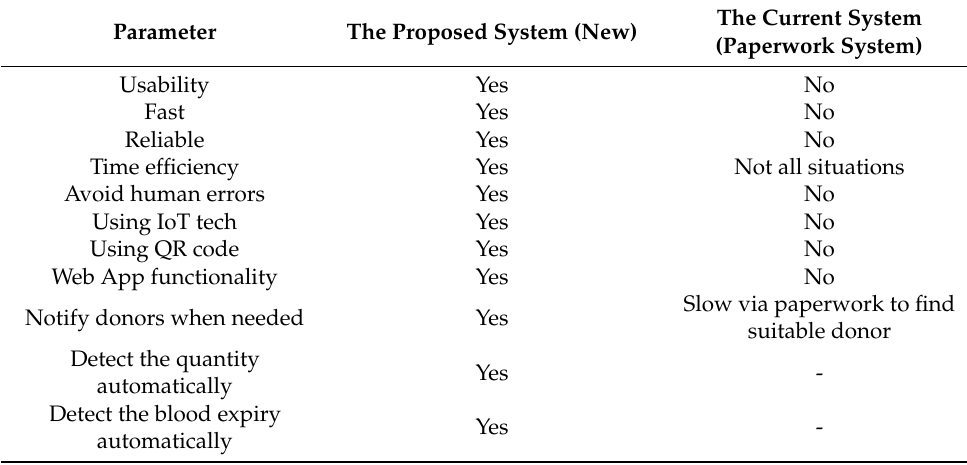
Figure 16. Overview of answers related to measured items. Table 13. Comparison of the proposed system with the paperwork-based